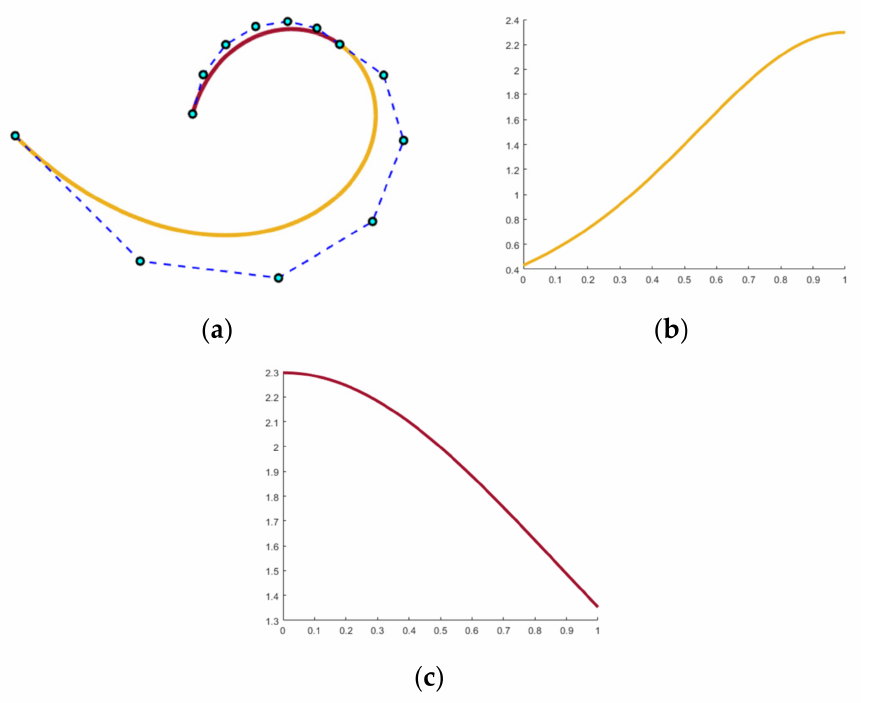
Figure 14. Results under subdivision. ( a ) Two typical curve segments join at t ∗ ; ( b ) first segment has increasing curvature variation; ( c ) second segment has decreasing curvature